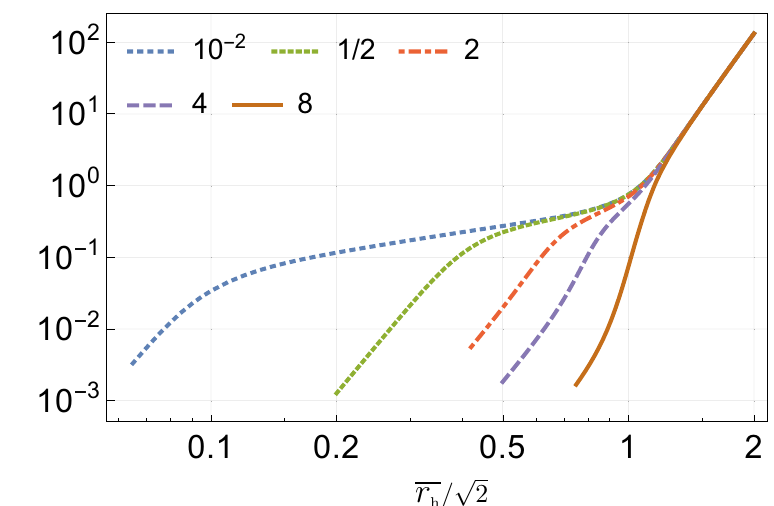
Figure 3 . Relation between temperature and horizon position at fixed values of the charge den- sity √ 2 N q